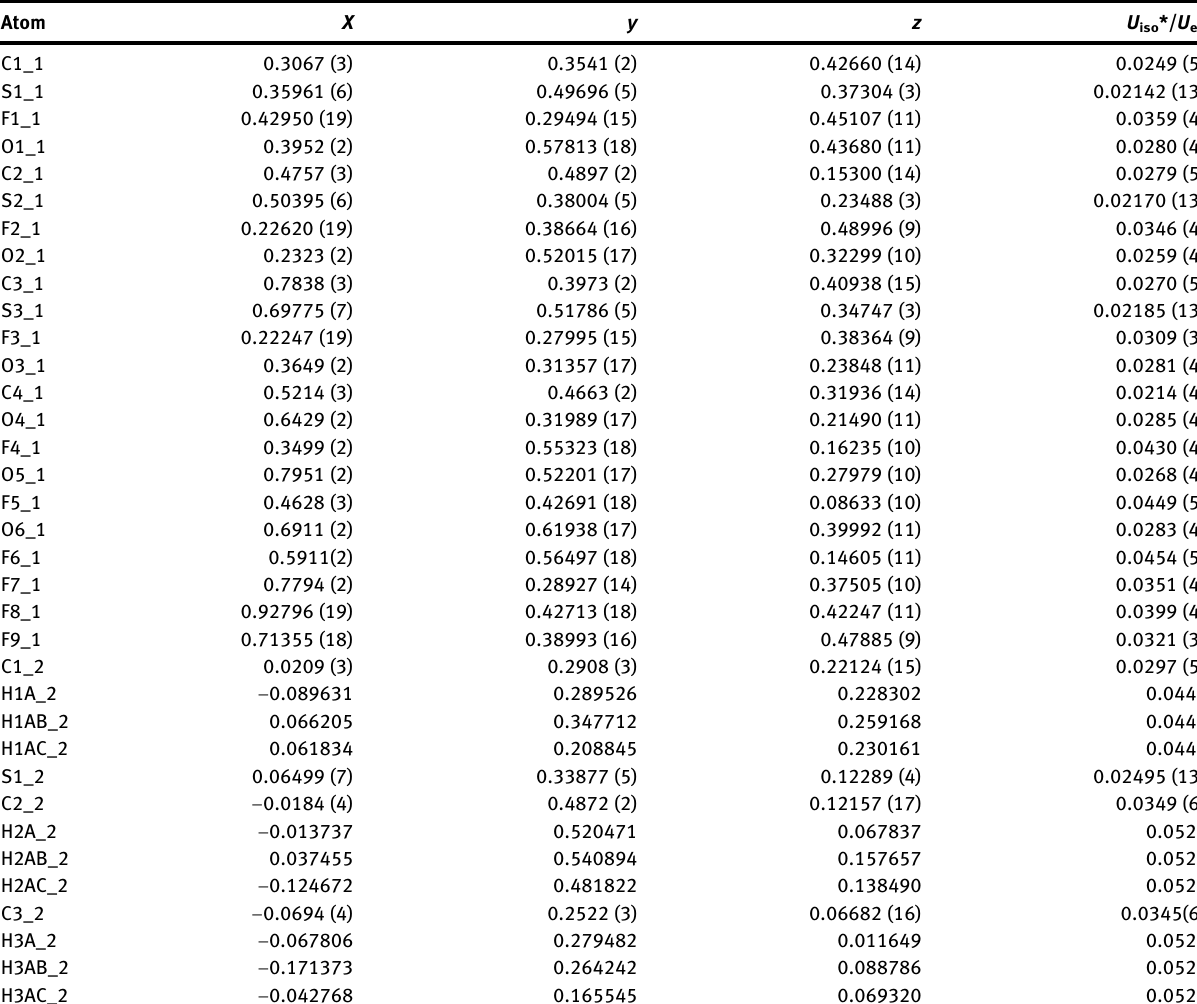
Table  : Fractional atomic coordinates and isotropic or equivalent isotropic displacement parameters (Å  ).